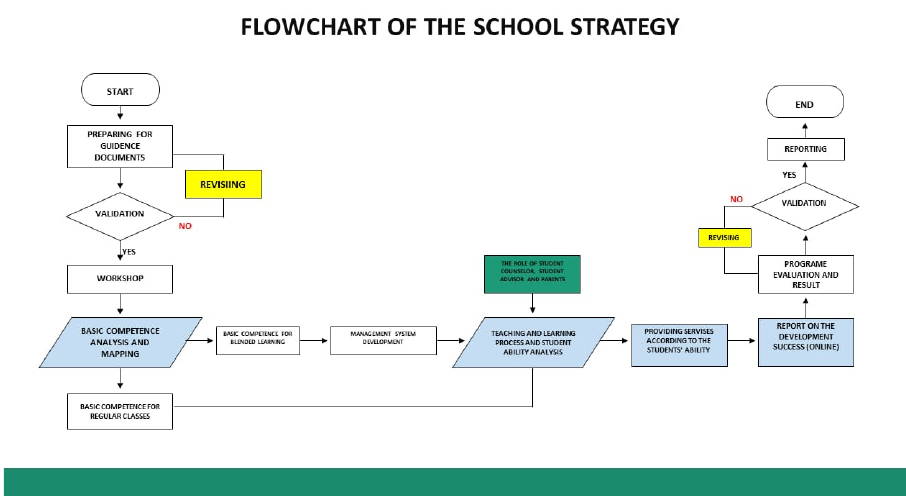
Figure 4. School strategy for service flowchart.